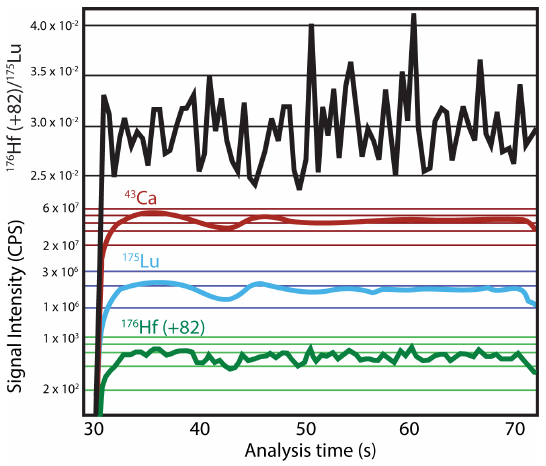
Figure 2. Time-resolved signals for 175 Lu / (176) Hf ( + 82), 43 Ca, 175 Lu, and (176) Hf ( + 82) demonstrating the effects of plasma load- ing on the signal intensities (i.e. dip in signal intensities at ∼ 10– 15s ablation) but not for the 176 Hf / 175 Lu ratio, which remains constant downhole. The time-resolved intensity of each analyte has been offset in the graph for better comparison; therefore the y axis scale is not continuous. Green horizontal lines show the scale for 176 Hf ( + 82), blue horizontal lines show the scale for 175 Lu, red horizontal lines show the scale for 43 Ca, and black horizontal lines show the scale for the 176 Hf ( + 82) / 175 Lu ratio. Presented data are from an analysis of MKED